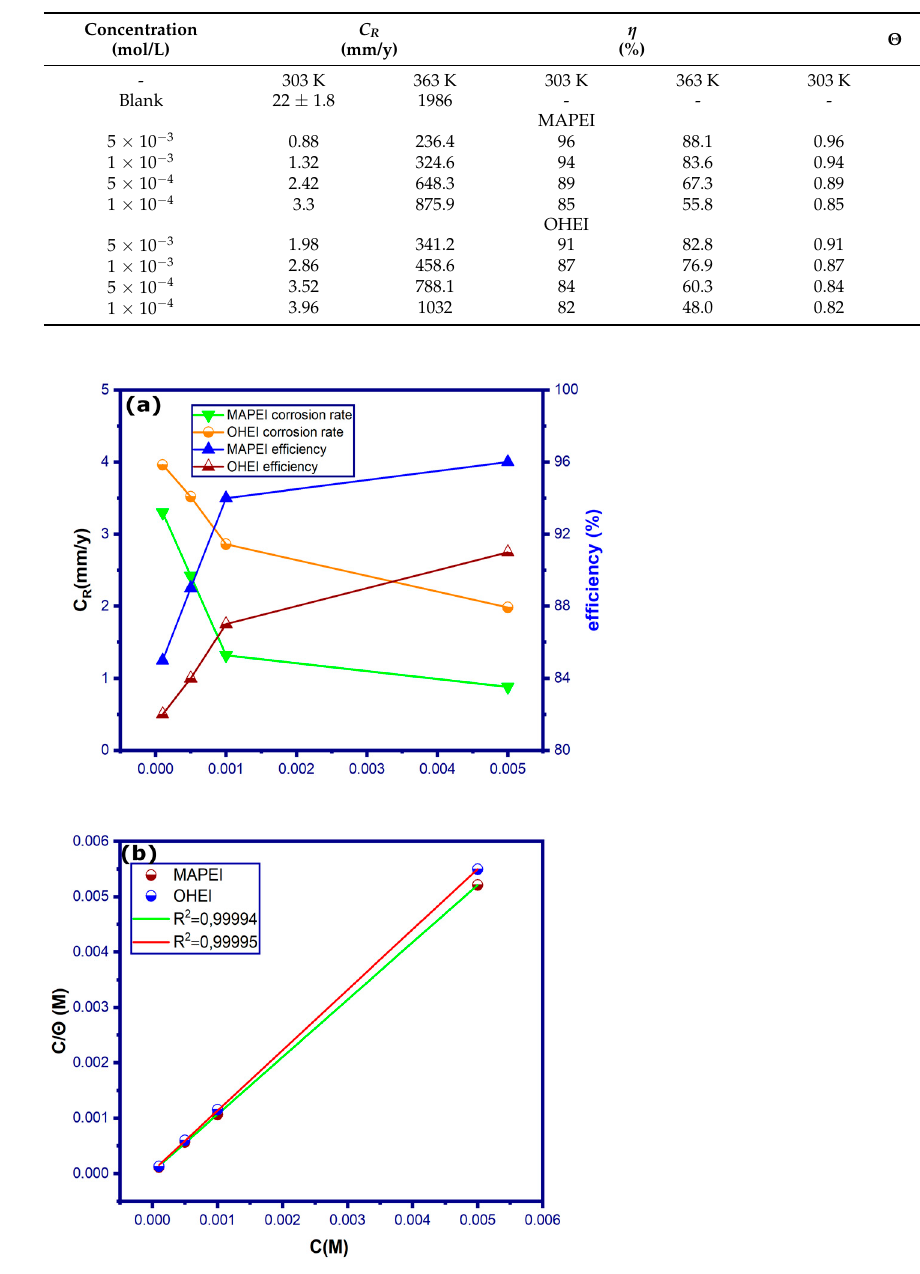
Figure 1. Relationship between corrosion rate, inhibition efficiency, and inhibitor concentrations for N80 steel after 24 h of immersion in 15 wt.% HCl inhibited with MAPEI and OHEI at 303 K ( a ) and Langmuir adsorption plots ( b ) for the adsorption of inhibitors on N80 steel surface.